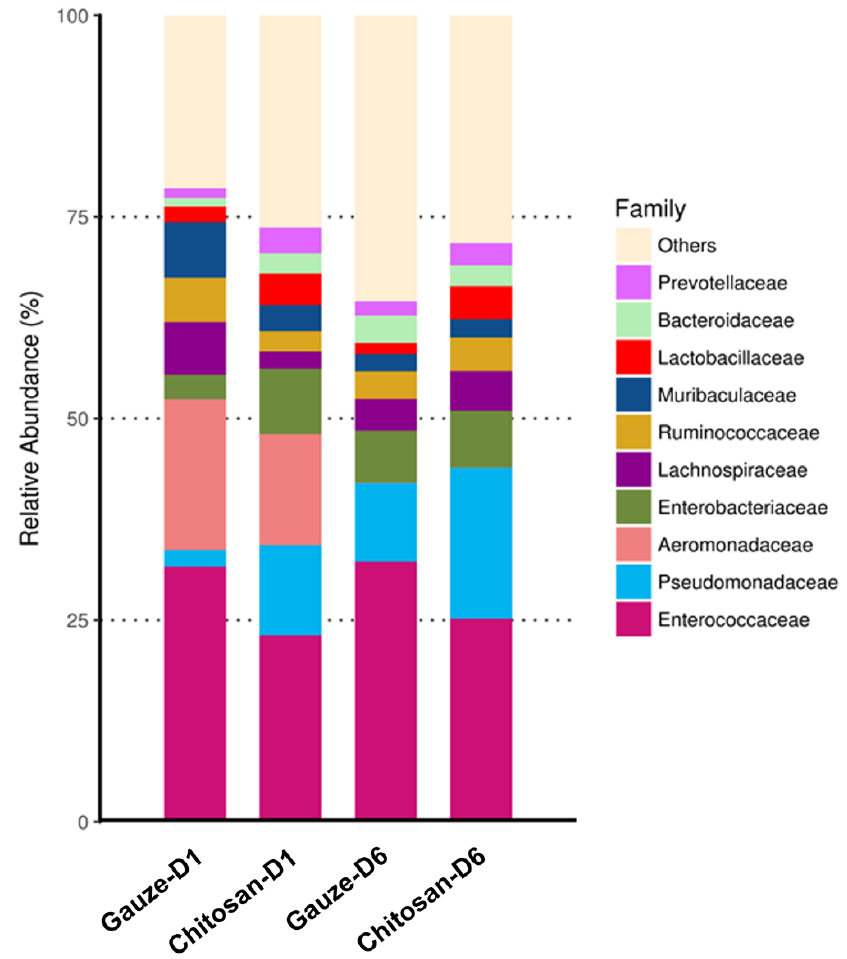
Figure 6. Relative abundance of most predominant bacteria identified in wound-contact chitosan and regular gauze dressings up to 6 d post-surgery (D1 = day 1, D6 = day 6).